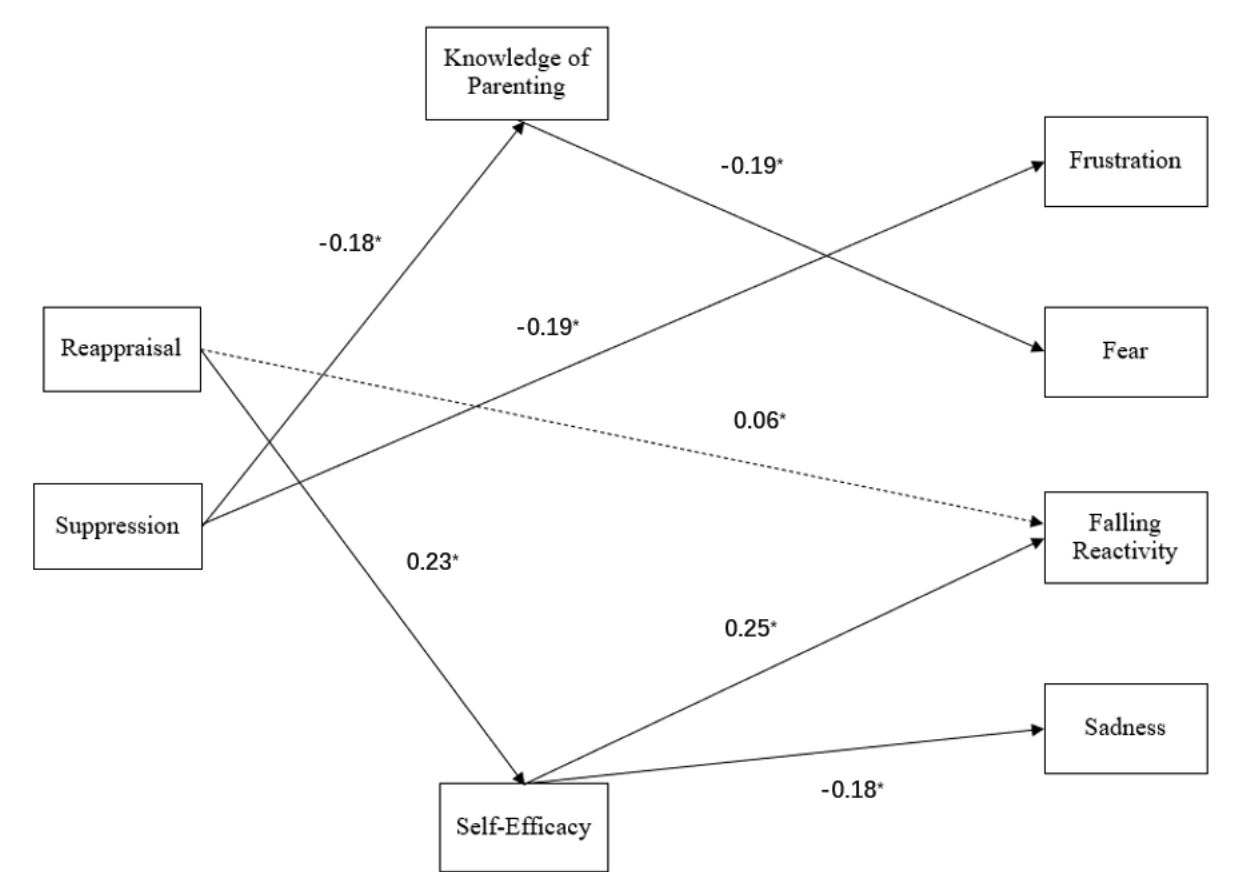
Figure 1. Final path model showing standardized coefficients between all primary variables in the